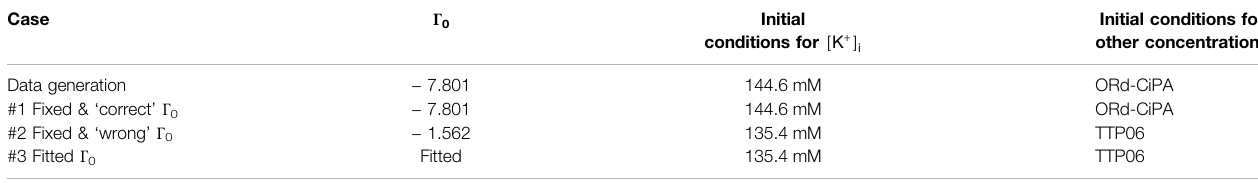
TABLE 2 | Initial conditions used in the various fi ttings of the ORd-CiPA model to synthetic data.